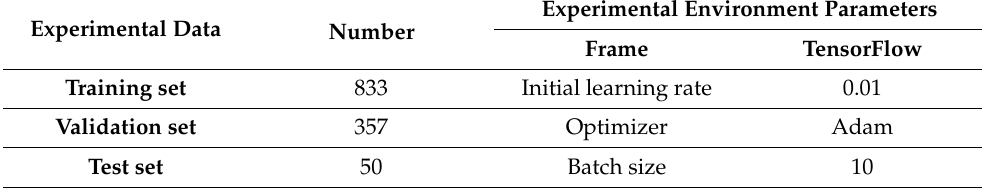
Table 2. Parameter